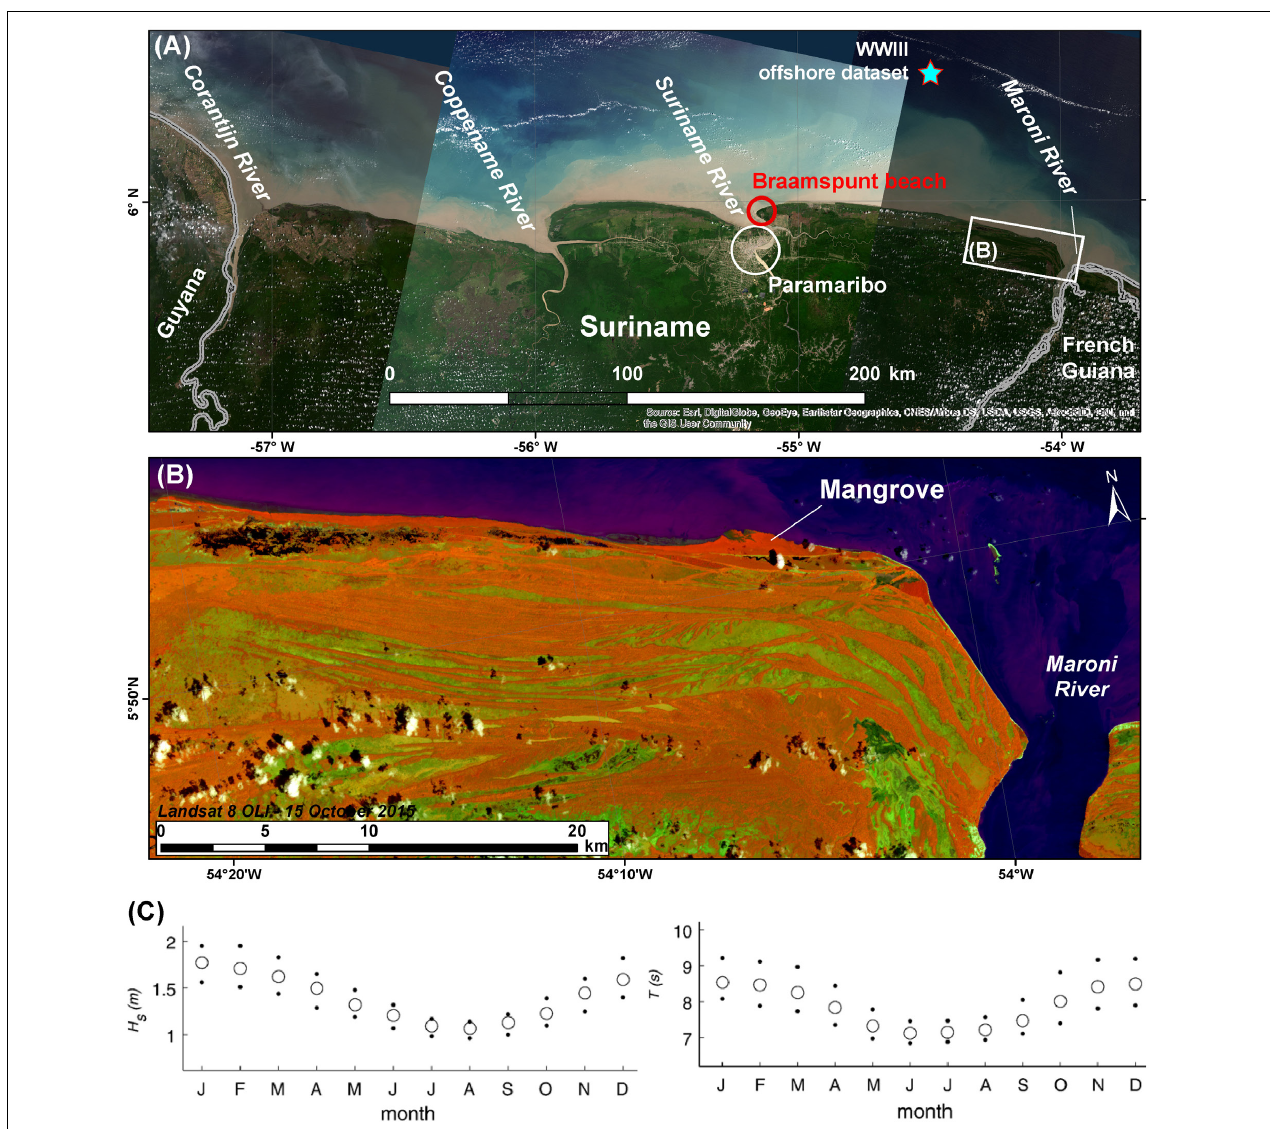
FIGURE 2 | Landsat image (2015) of the Suriname coast, location of Braamspunt chenier near the mouth of the Suriname River, and offshore WWIII data collection point for the field study (A) ; Landsat image (2015) showing cheniers (vegetation in dark orange) separated by linear swamp depressions (light green) and running west from the mouth of the Maroni River between Suriname and French Guiana (B) . The diversity in orientation, length, width, and grouping of these cheniers reflect space- and time-varying bank and inter-bank dynamics. The dark red hue along the coast represents seafront mangrove swamps; (C) daily averages of wave-climate parameters, significant wave height H s and wave period T , derived from a 44-year record of the ERA-40 (European ReAnalysis) wave dataset generated by the European Centre for Medium-Range Weather Forecasts (ECMWF) for the location 5 ◦ N, 52 ◦ W (modified after Gratiot et al., 2007). Dots correspond to the first and third inter-quartiles, and circles to the median